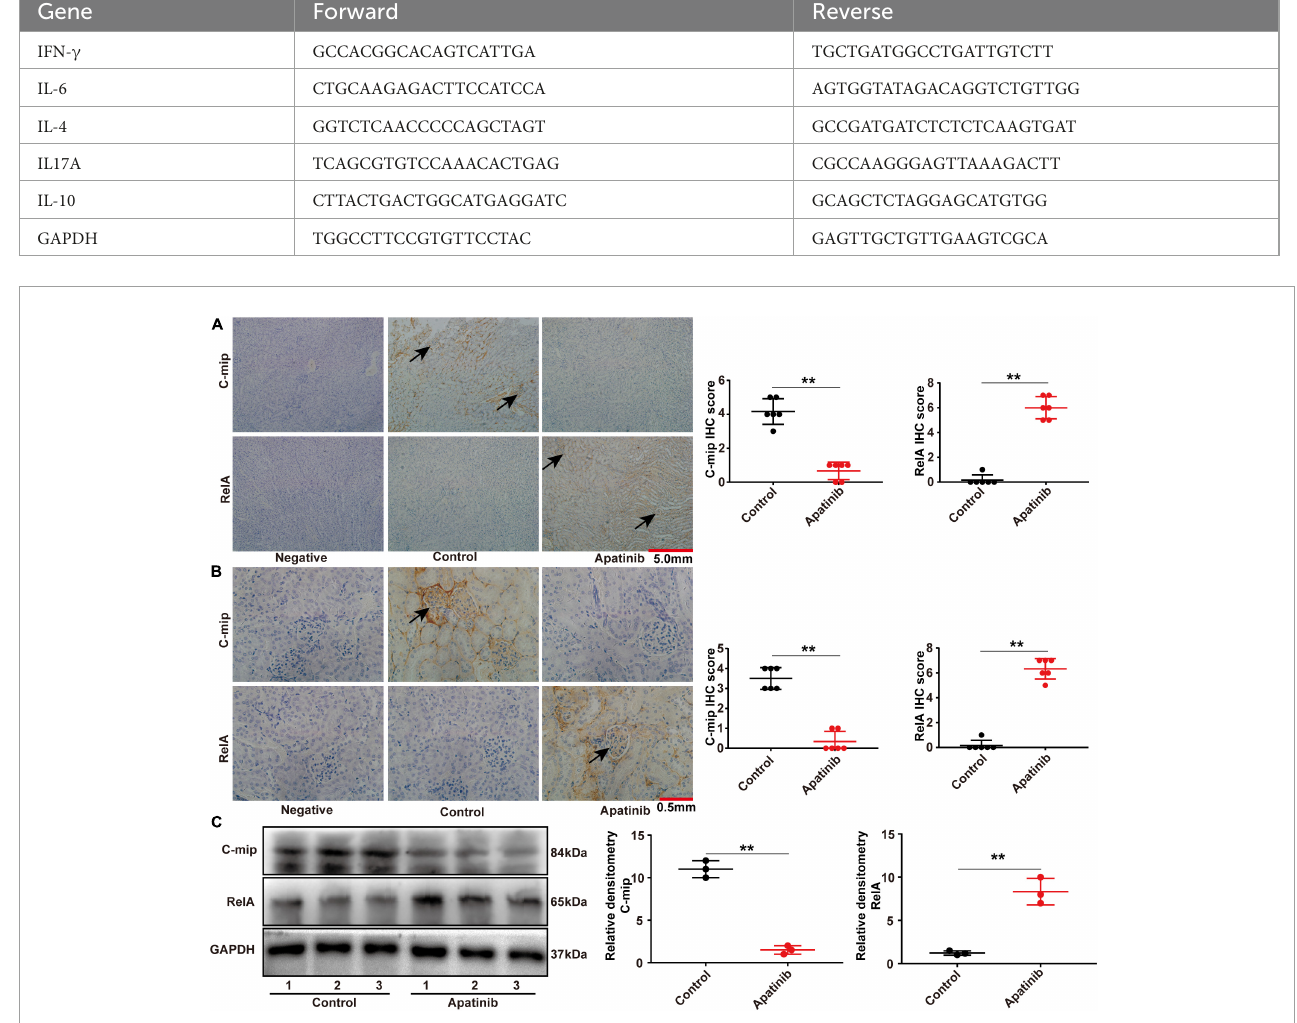
FIGURE1 TKIs promotes the expression of RelA in glomeruli and tubules. (A,B) Representative images of immunohistochemistry and staining scores of RelA and c-mip in the kidney tissues of mice ( n = 6, each group). (C) RelA and c-mip in mouse kidneys analyzed by Western blotting ( n = 3, each group), ** p < 0.01.